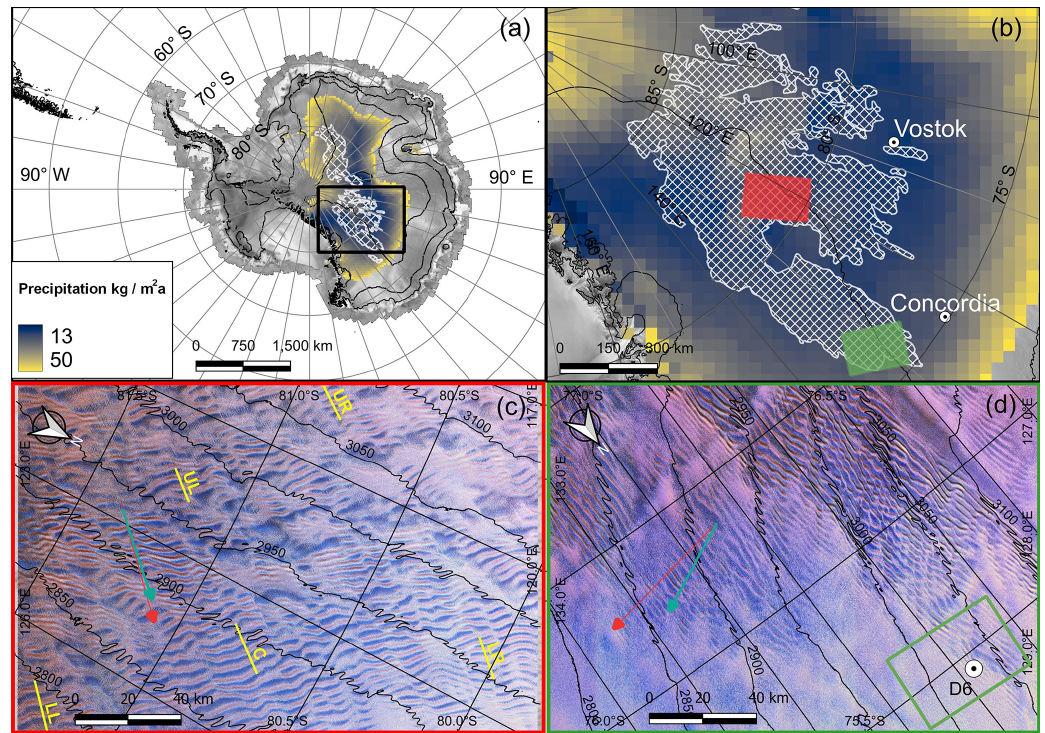
Figure 1. Location map of megadune area. (a) Satellite image map of the Antarctic continent (Jezek, 1999) with elevation contour lines at 1000ma.s.l. intervals; megadune regions are shown as cross-hatched white areas (Fahnestock et al., 2000), with snow precipitation by RACMO (Regional Atmospheric Climate Model) in colour for areas with precipitation < 50kgm 2 a − 1 (Van Wessem et al., 2014) (black rectangle, b ). (b) The megadune field with two study sites, EAIIST (red rectangle, c ) and It-ITASE (green rectangle, d ). (c) Landsat 8 OLI (Operational Land Imager) image in false colour (scene 069119 on 17 December 2015) of the EAIIST area. (d) Landsat 8 OLI image in false colour (scene 081114 on 18 December 2014) of the It-ITASE area and D6 core site; the green rectangle shows the location of Fig. 4. In panels (c) and (d) , red arrows represent ERA5 wind direction and green arrows represent sastrugi-based wind direction, while the yellow lines show the location of the transects